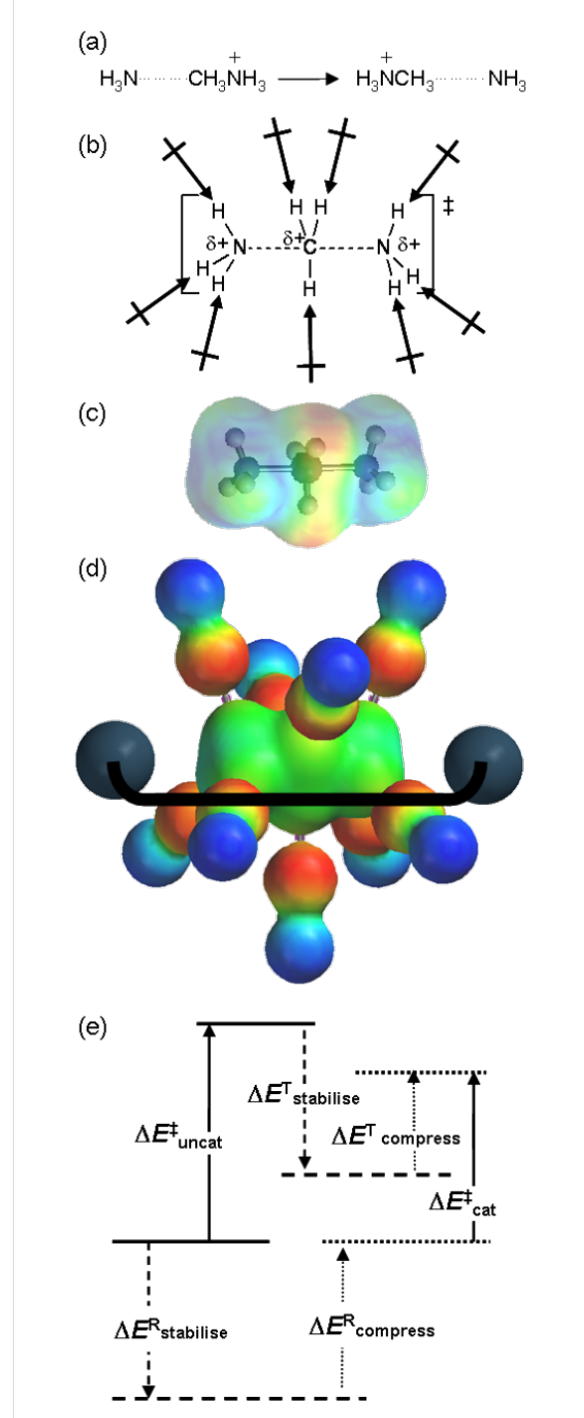
Figure 3: Catalyst design for methyl transfer: (a) the reaction to be catalysed; (b) dipoles favourably aligned with the transition structure; (c) electrostatic potential plotted on the isodensity contour surface of the transition structure; (d) electrostatic potential (on isodensity contour surface) of the complex of the transition structure within a frozen array of dipoles, together with a pair of inert-gas atoms; (e) preferential TS stabilisation as the net result of stabilising (attractive) and destabilising (repulsive, compressing)